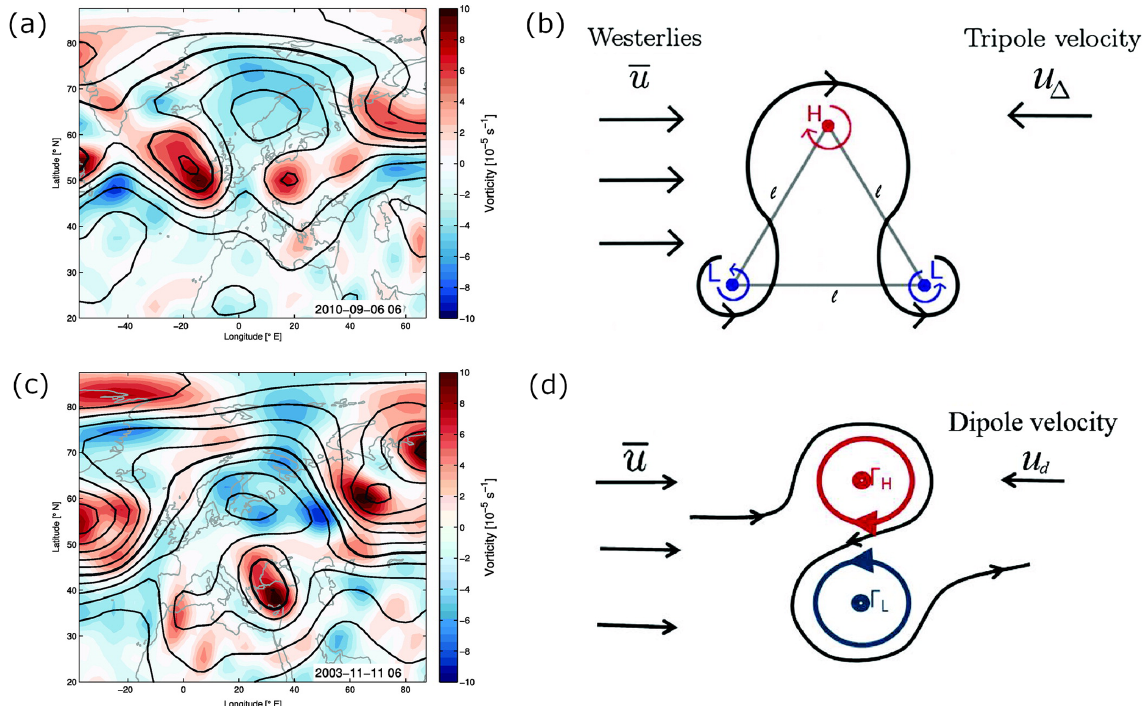
Figure 1. Application of point vortex theory to two distinct atmospheric blocking types: (a, b) omega blocking, (c, d) high-over-low block- ing. (a, c) Two exemplary blocking events observed at the 500hPa level: displayed is the relative vorticity (color-shaded) and contours of geopotential height in 8dm intervals (bold contour represents 552dm). (b, d) Illustration of how the corresponding blocking can be realized in the point vortex model. Figure is adapted from Hirt et al. (2018, their Fig. 2; published under the terms of the Creative Commons Attri- bution License (http://creativecommons.org/licenses/by/4.0/, last access: 12 September 2021)) with the upper right figure taken from Müller et al. (2015). The point vortex systems become stationary if the typical westerly flow of the mid-latitudes and the propagation speed of the dipole or tripole point vortex systems are of equal